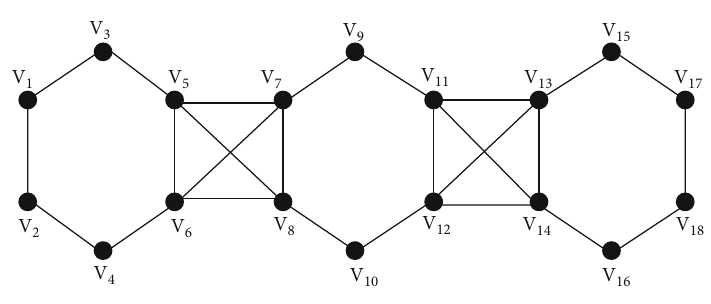
Figure 2: Line graph of para chain hexagonal cactus L ð H